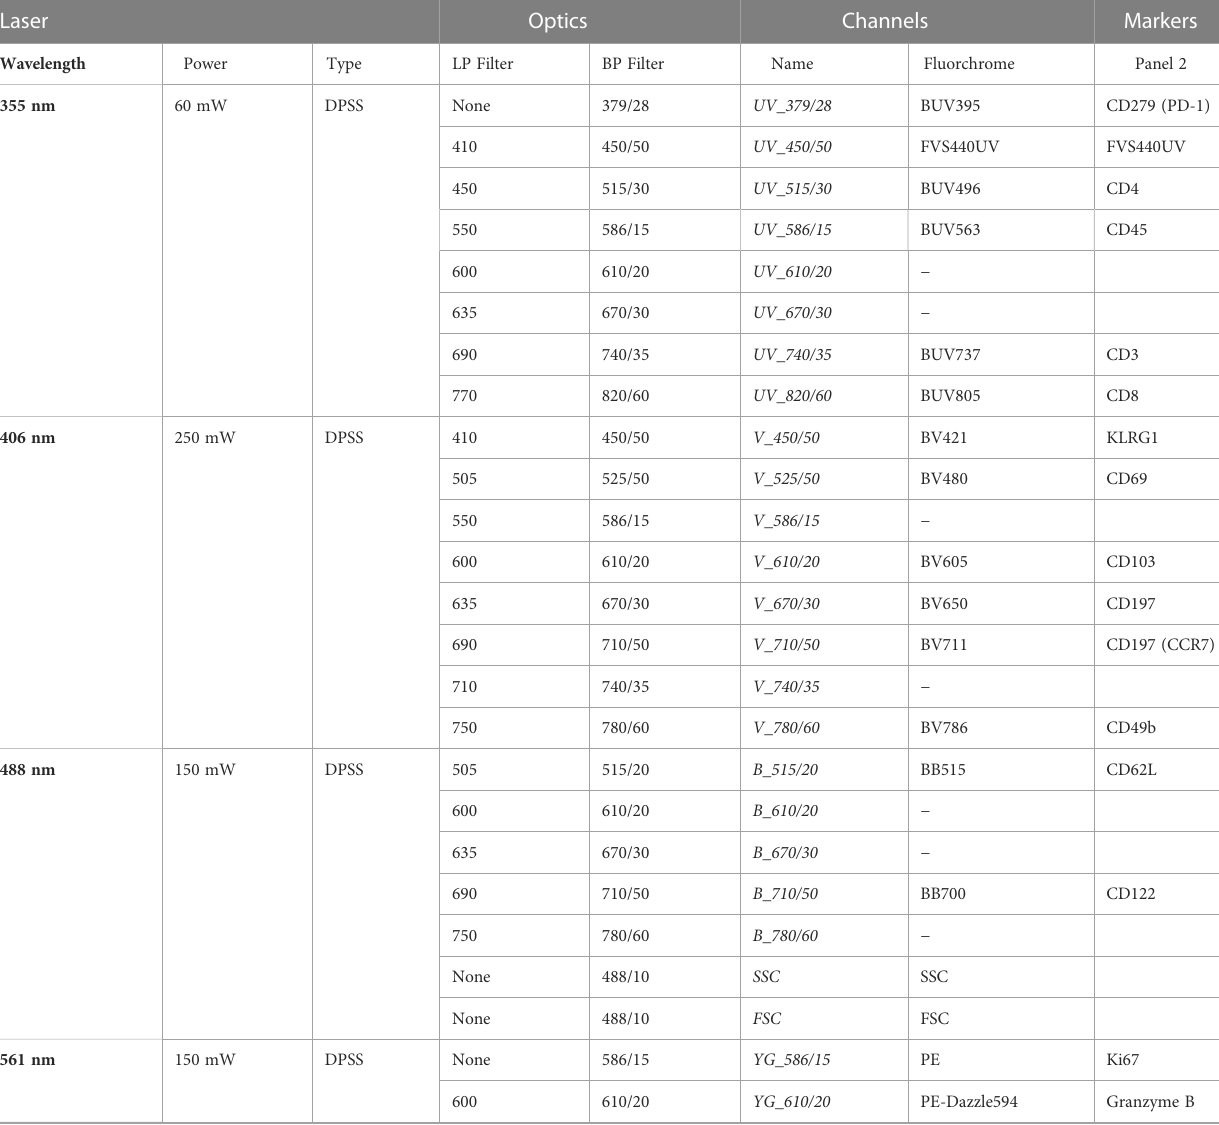
TABLE 5 Instrument Con fi guration for Panel